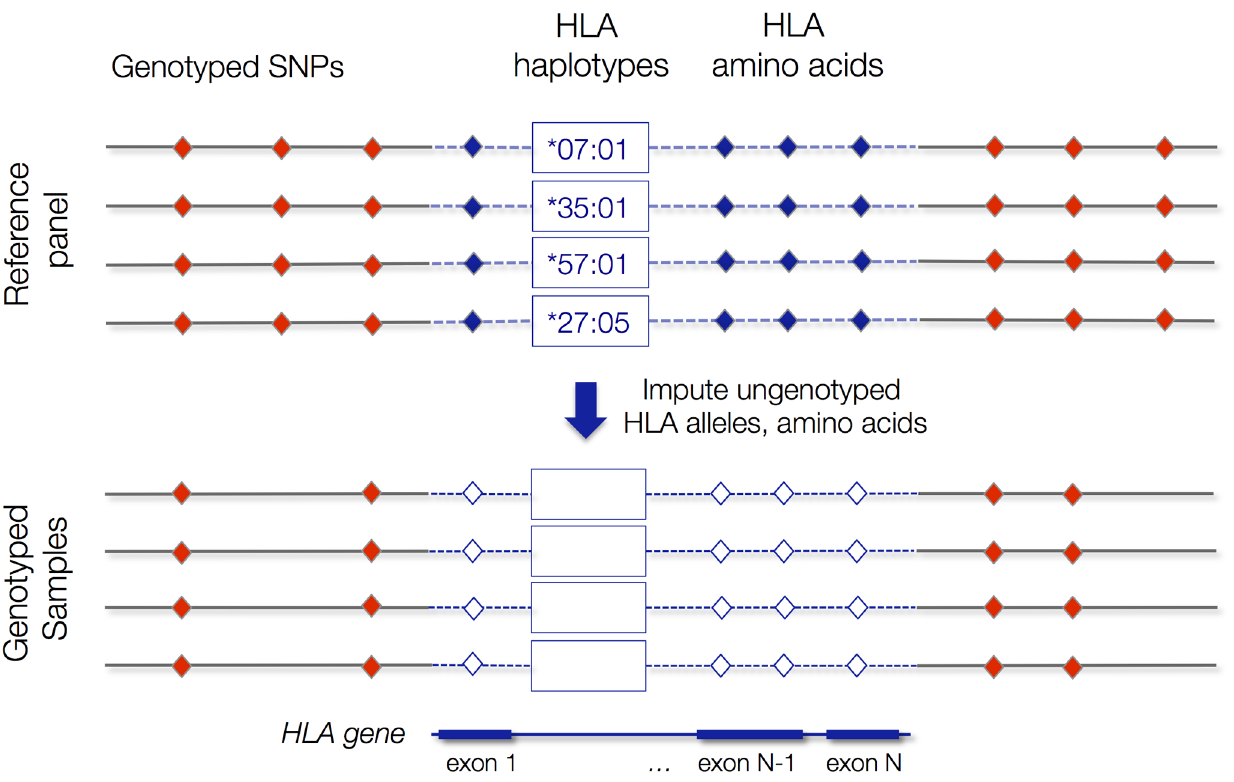
Figure 1. Overview of the SNP2HLA imputation procedure. The reference panel (top) contains SNPs in the MHC, classical HLA alleles at the class I and class II loci, and amino acid sequences corresponding to the 4-digit HLA types at each locus. For a data set with genotyped SNPs across the MHC (bottom), we use the reference panel to impute classical alleles and their corresponding amino acid polymorphisms.